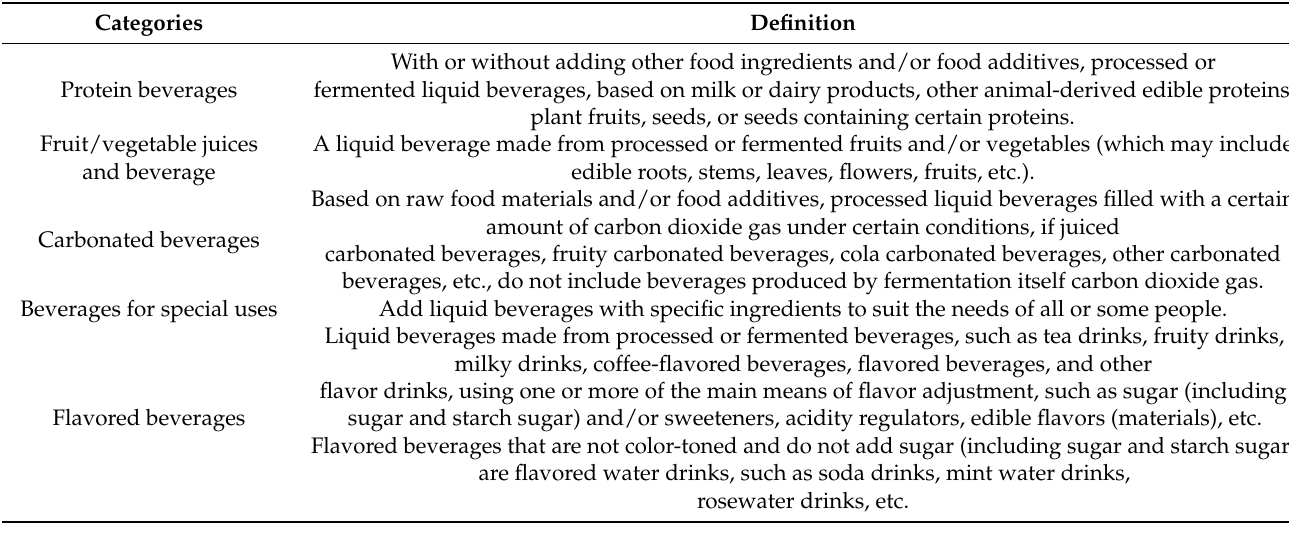
Table A1. Definition of each category of